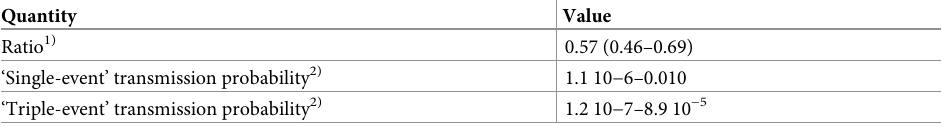
Table 3. The risk of HPAI transmission jumps from one area to another, due to a compartment with one farm located in the DPPA. Quantity